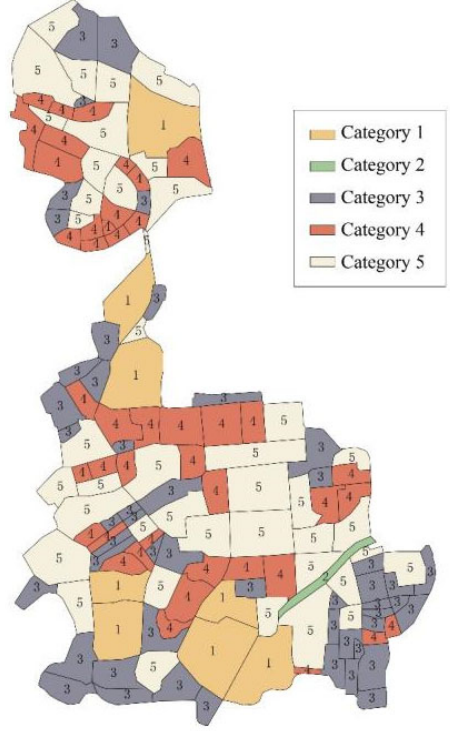
Figure 9. K-means clustering Figure 9. K ‐ means clustering results.